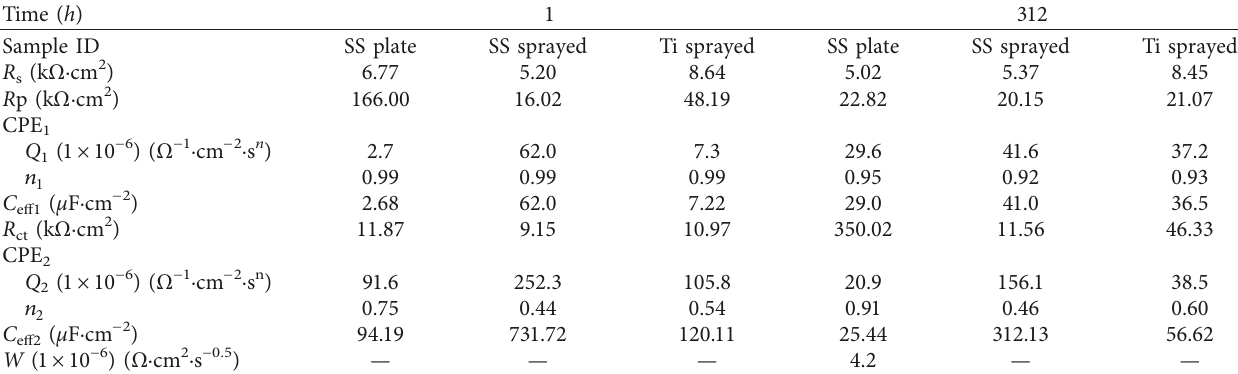
Table 1: Electrochemical parameters of the SS plate, SS-sprayed coating, and Ti-sprayed coating extracted after fitting of EIS data to suitable EECs with different exposure periods in pH 4